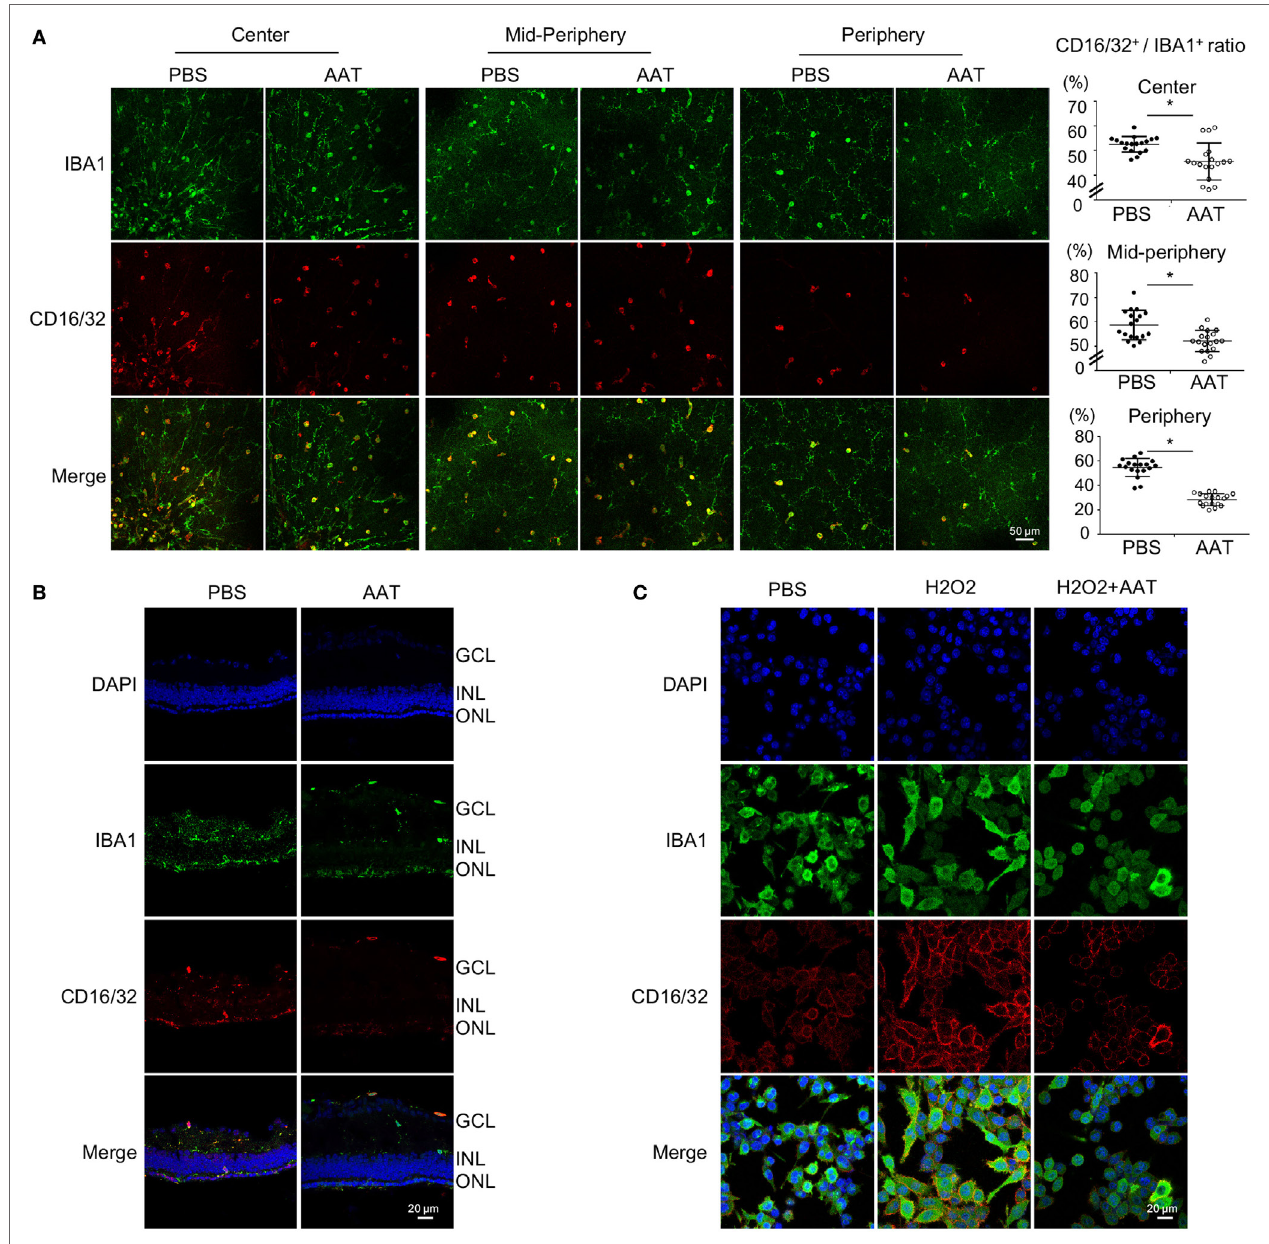
FigUre 6 | Alpha-1 antitrypsin (AAT) suppressed pro-inflammatory M1 microglial polarization during retinal degeneration. (a) . In retinal whole mounts, the amount of CD16/32 + IBA1 + M1 microglia in the central, mid-peripheral, and peripheral retina decreased significantly after AAT supplement. Scare bar, 50 µm. Depicted is mean ± SEM of three fields/eyes from six eyes. * p < 0.05 (two-tailed unpaired t -test). (B) In the retinal section, CD16/32 + IBA1 + microglia prominently accumulated in the outer nuclear layer in PBS treatment group whereas the amount of CD16/32 + IBA1 + pro-inflammatory microglia significantly decreased in the AAT-treated group. Scare bar, 20 µm. (c) In the cultured microglia under oxidative stress by hydrogen peroxide stimulation, AAT supplement significantly suppressed the pro- inflammatory M1 phenotype of microglia, presenting with less CD16/32 + cells co-stained with IBA1 + cells. Scare bar, 20